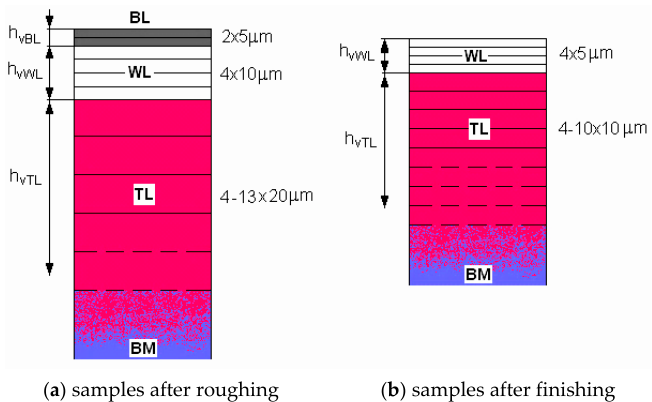
Figure 7. Composition of experimental metallographic sections for assessment of microhardness change in particular layers, and for assessment of total HAZ thickness of tool steel EN X32CrMoV12-28 after die-sinking EDM roughing and finishing with a SF-Cu